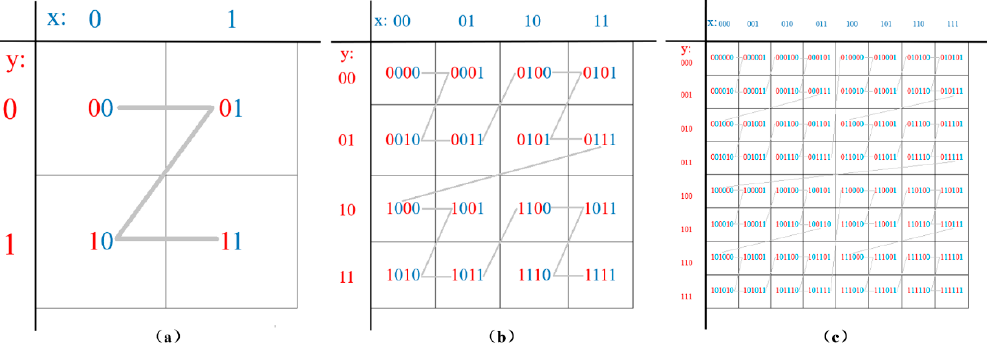
Figure 1. Multilevel space division following a hybrid implementation encoding. ( a ) is the first-level division grid; ( b ) is the second-level division grid; ( c ) is the third-level division grid.